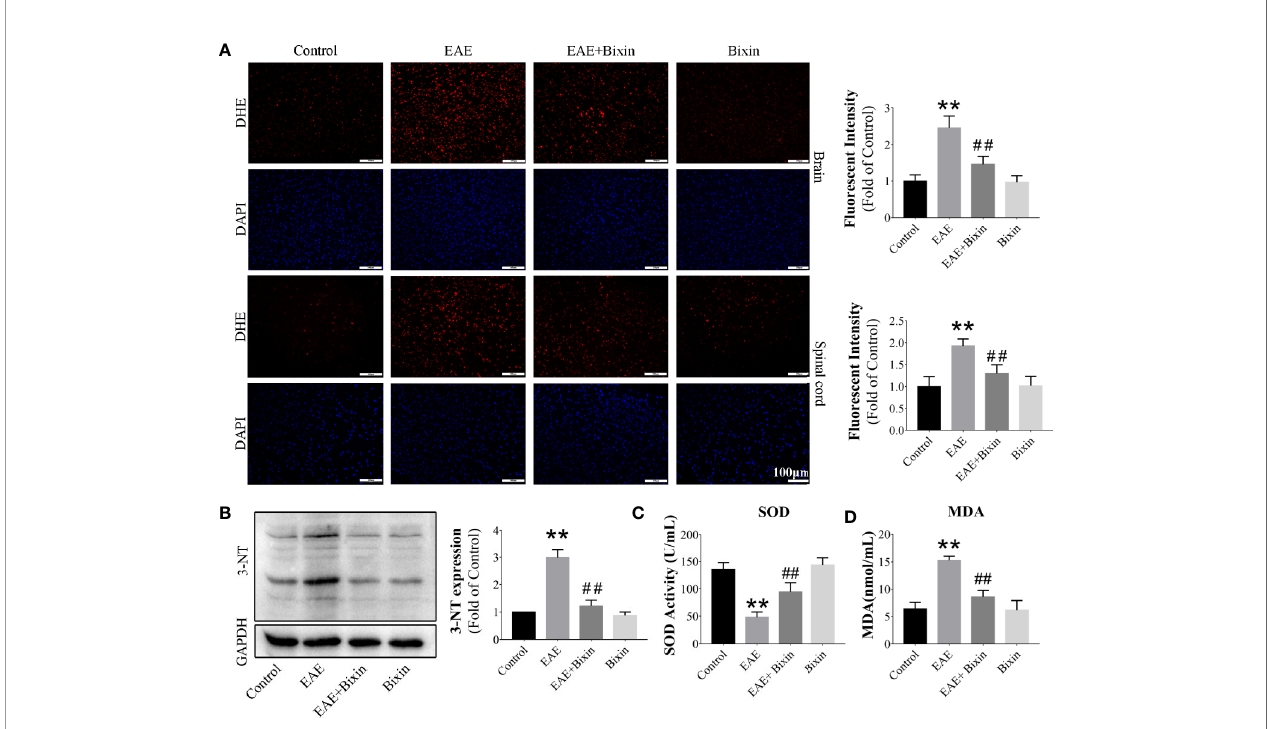
FIGURE 5 | BixinalleviatesoxidativestressinEAEmice (A) .Thelevelofreactiveoxygenspecies(ROS)inthebrainandspinalcordtissueswasassessedbyDHEstaining,andthe quantitativeresultsareshown.Scalebars:100 m m (B) .Theproteinlevelof3-NTintheCNStissueswasassessedbywesternblotting,andthequantitativeresultsareshown (C) . TheactivitiesofSODand (D) thelevelsofMDAintheserum.Datashowningraphsrepresentsthemeans±SD(n=5).**P<0.01, vs. controlgroup; ## P<0.01, vs.